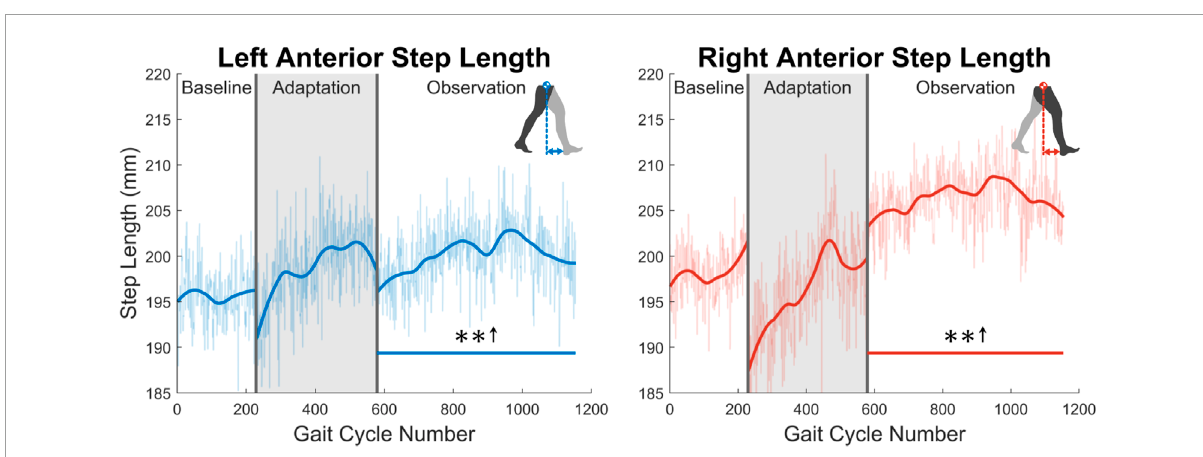
FIGURE 15 Left and right anterior step length averaged for all 12 subjects. Anterior step length was calculated as the anterior/posterior distance between the center of mass and the leading heel at heel strike. Significance is shown in the observation phase as compared to the baseline phase by the significance line. All significance testing was performed on “unsmoothed” data (seen in the lighter line). The darker line is the data smoothed by 2nd-degree polynomial local regression and was added only to allow the reader to more clearly see trends in the